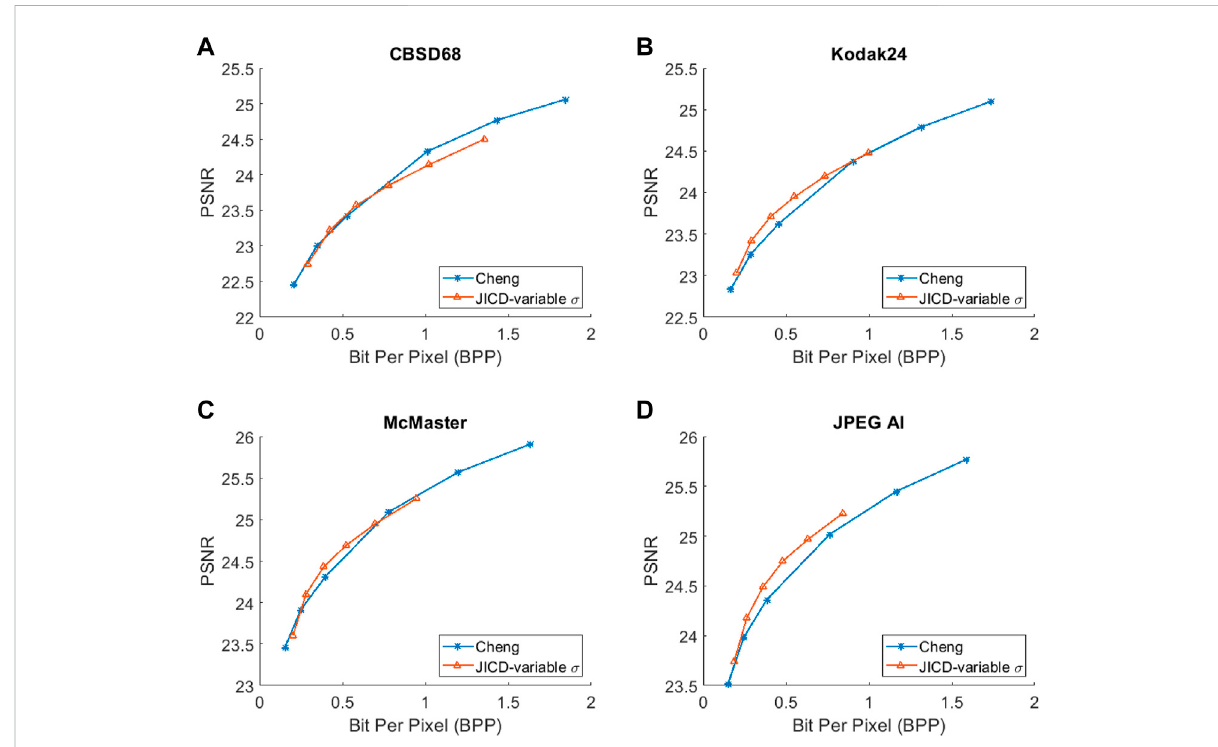
FIGURE 12 The rate-PSNR curves for noisy input reconstruction. (A) CBSD68, (B) Kodak24, (C) McMaster, (D)